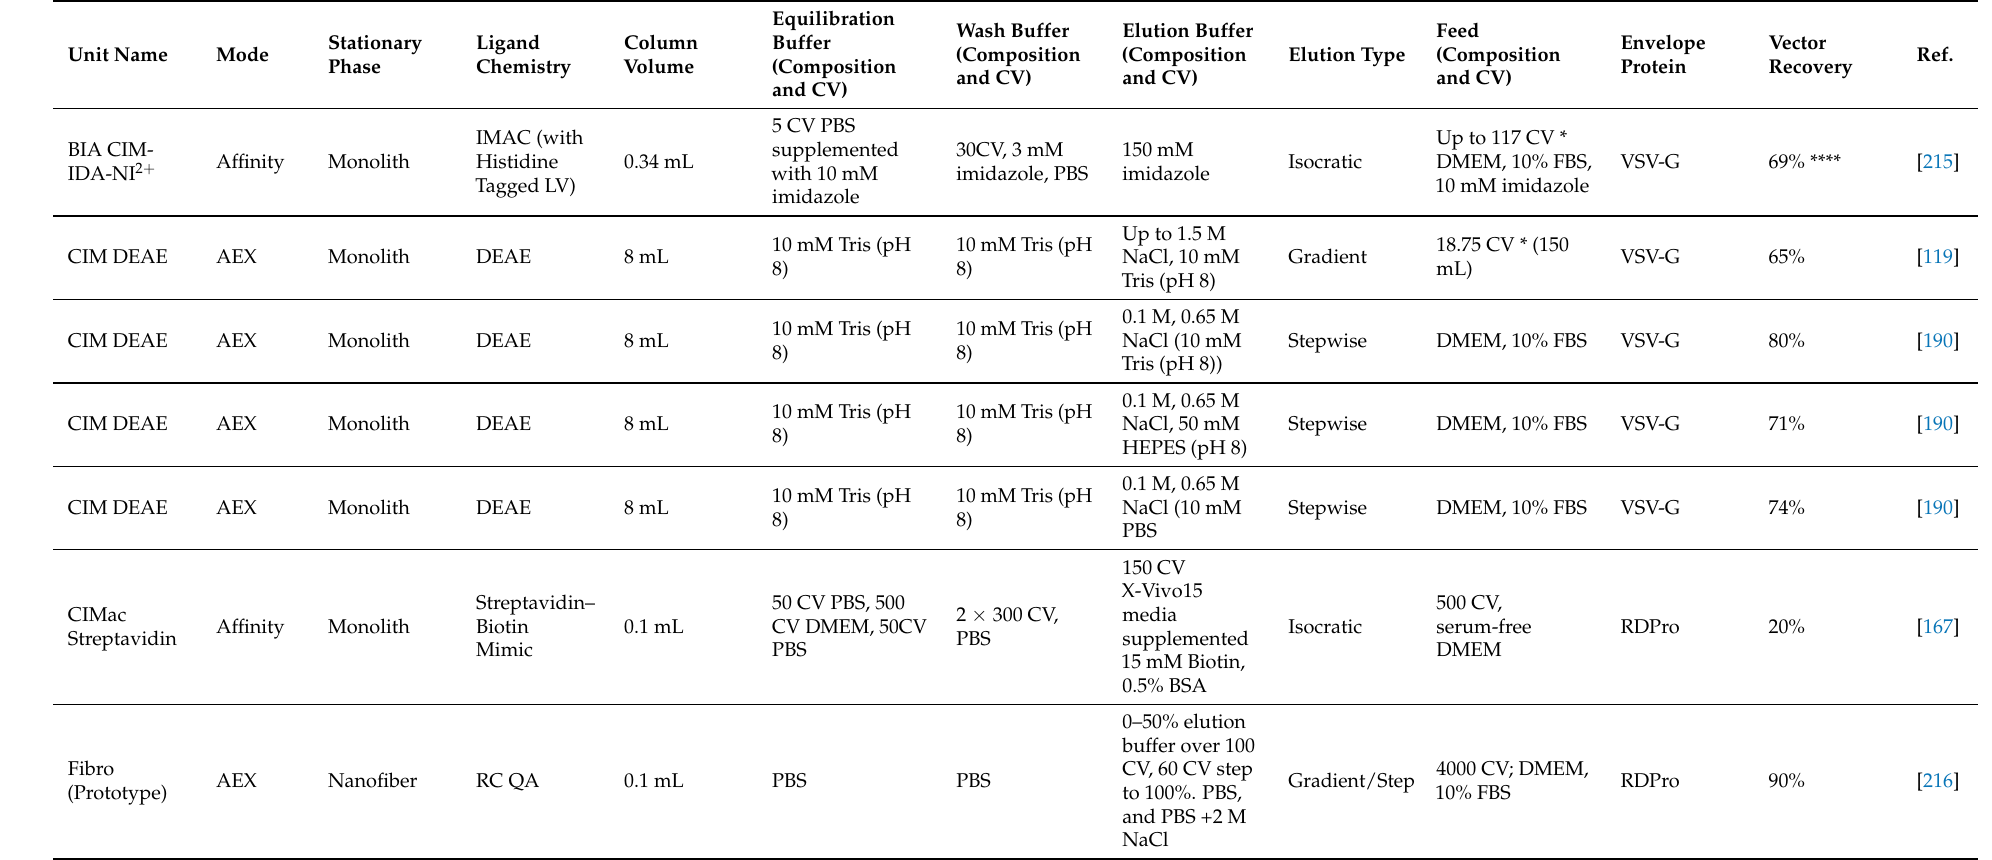
Table 6. Example of chromatographic operations in lentiviral vector